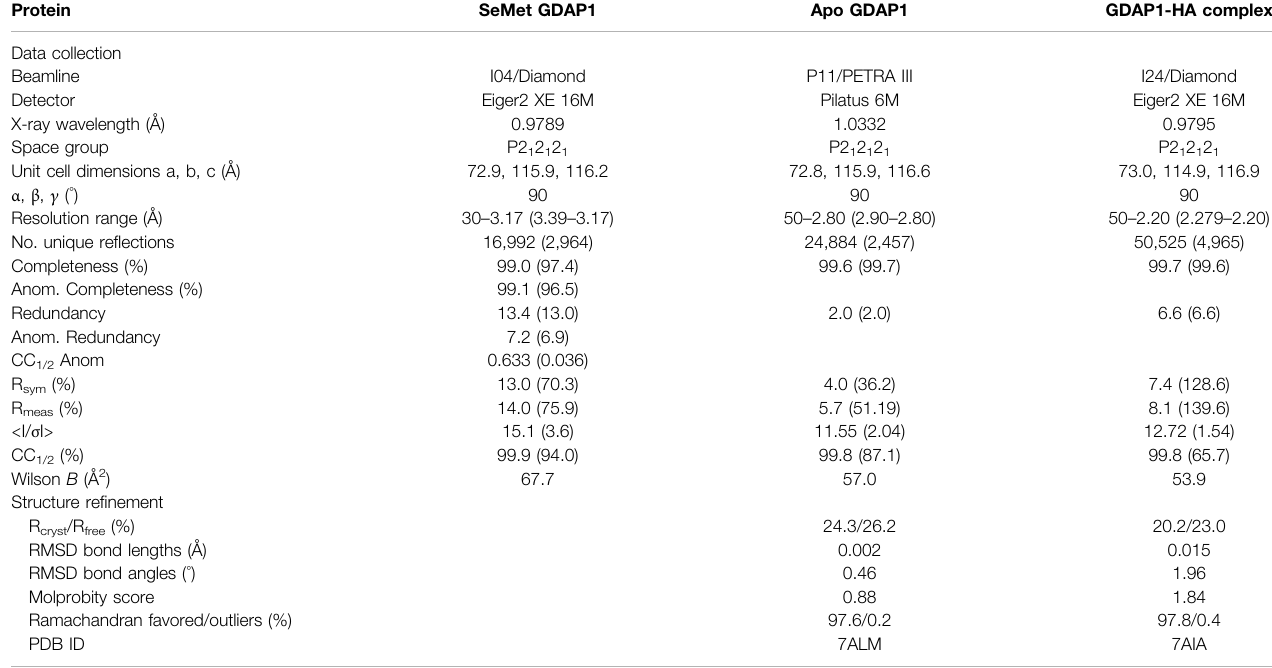
TABLE 1 | Diffraction data processing and re fi nement statistics. Protein SeMet